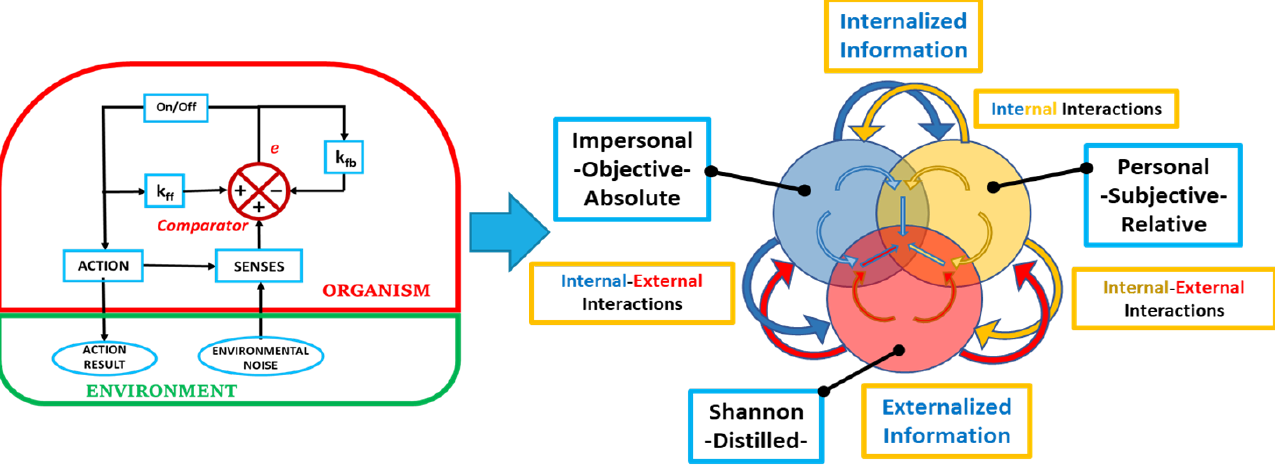
Figure 3. The process of info-autopoiesis.